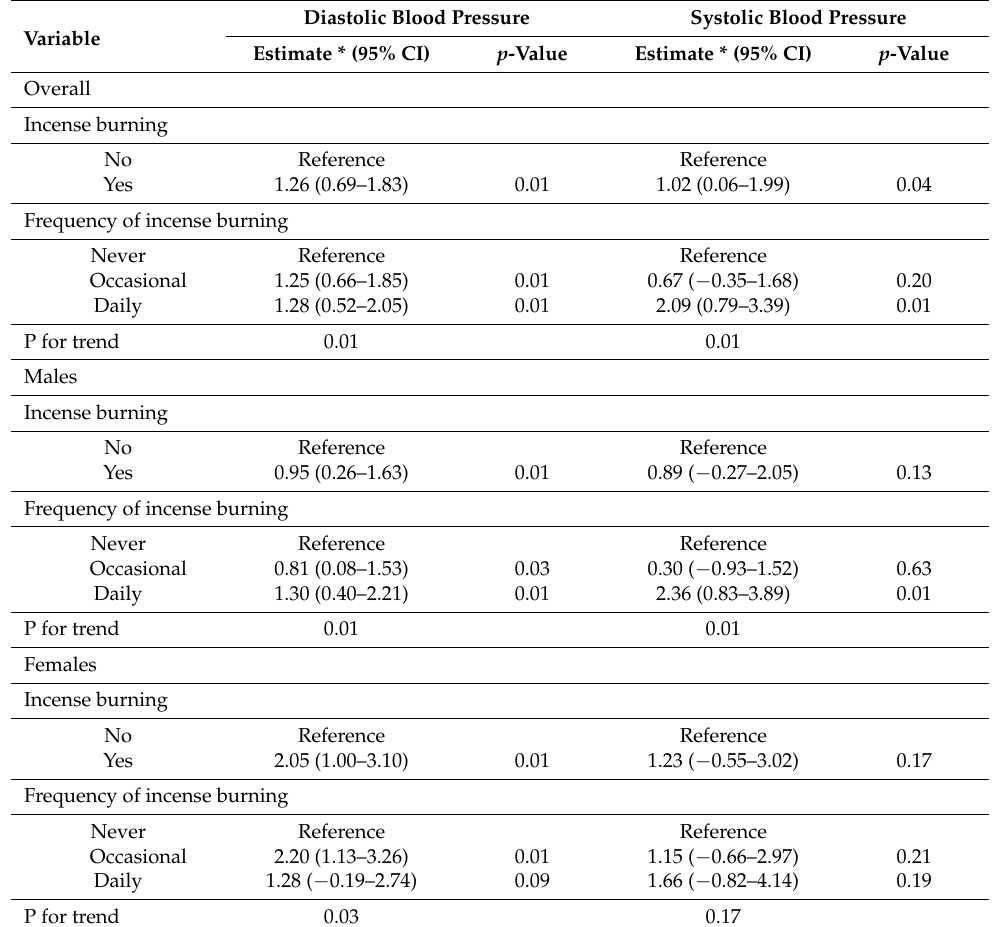
Table 3. Estimated absolute increase in mean arterial blood pressures (mmHg) with 95% CI associated with domestic incense